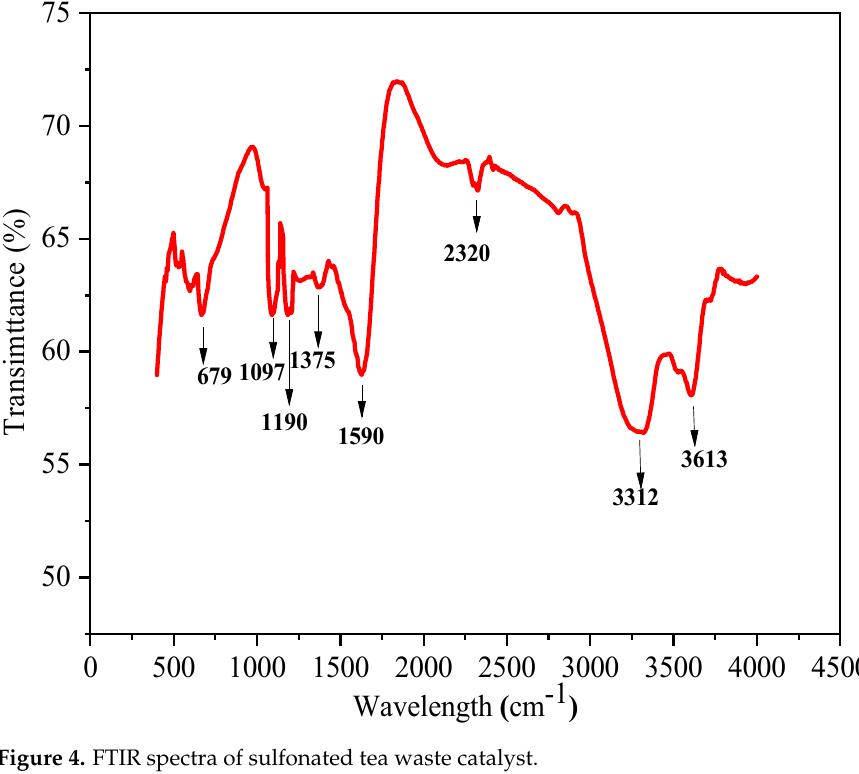
Figure 4. FTIR spectra of sulfonated tea waste catalyst.